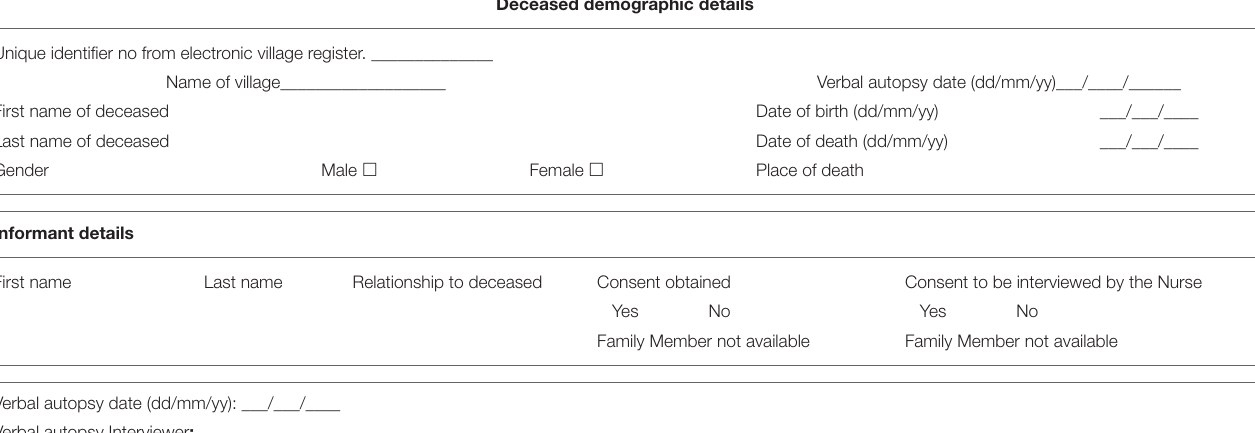
Deceased demographic